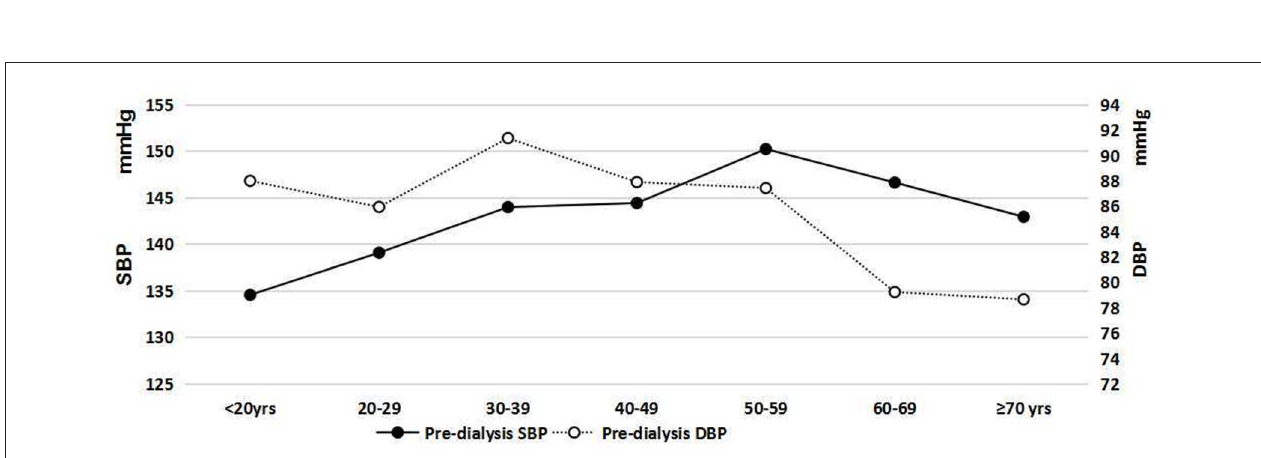
FIGURE 5 | (A) Pre-dialysis systolic and diastolic blood pressure of patients with DN. (B) Pre-dialysis systolic and diastolic blood pressure of patients with non-DN.